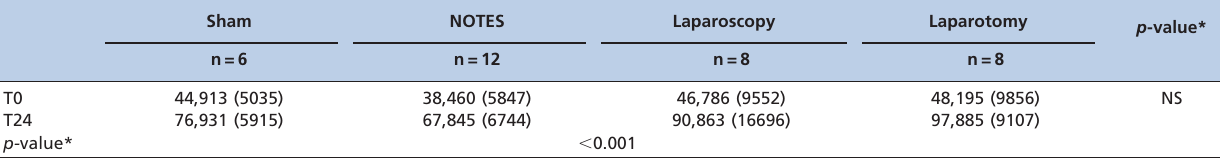
Table 4 - C-reactive protein measurements at T0 and